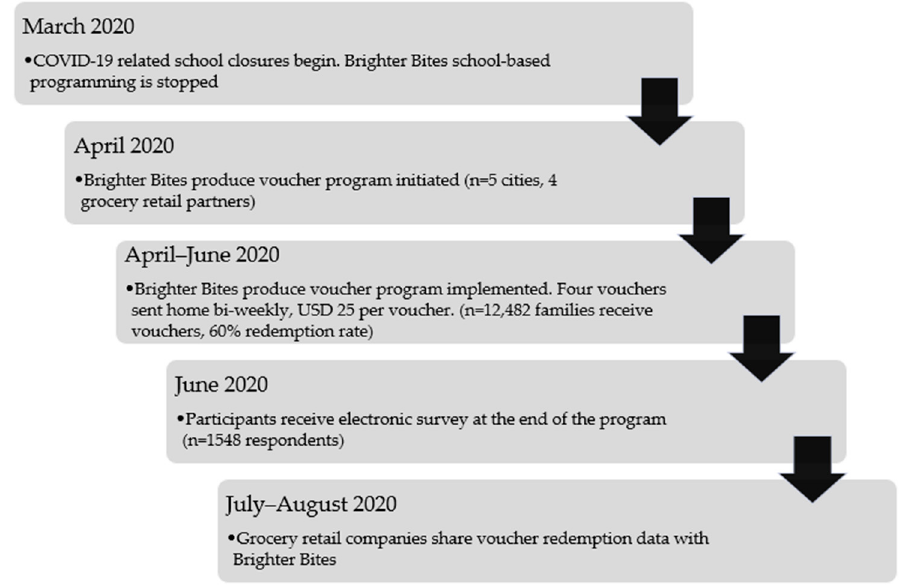
Figure 1. Methodological flowchart of the Brighter Bites produce voucher program im- plementation.